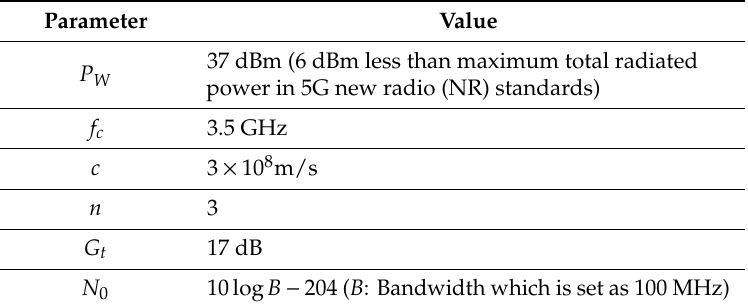
Table 4. The used simulation parameters in Figure 6.